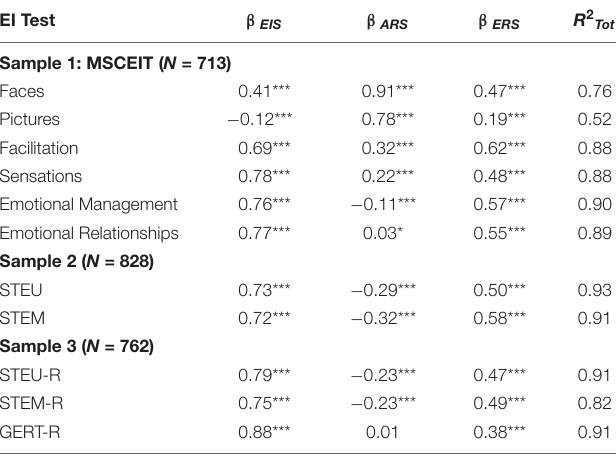
TABLE 5 | Regression of PSM scatter on PCM Emotional Intelligence Scores, Acquiescent Responding Scores, and Extreme Responding Scores for each EI